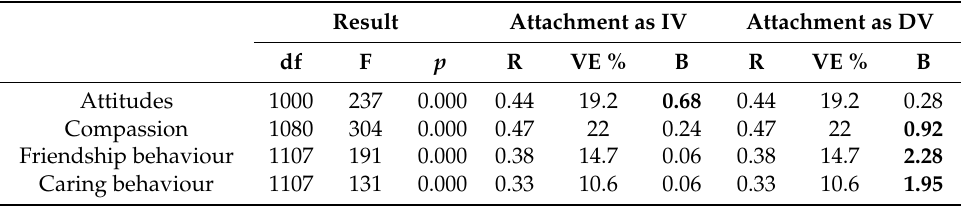
Table 5. Results from regression analysis for attachment to pets.